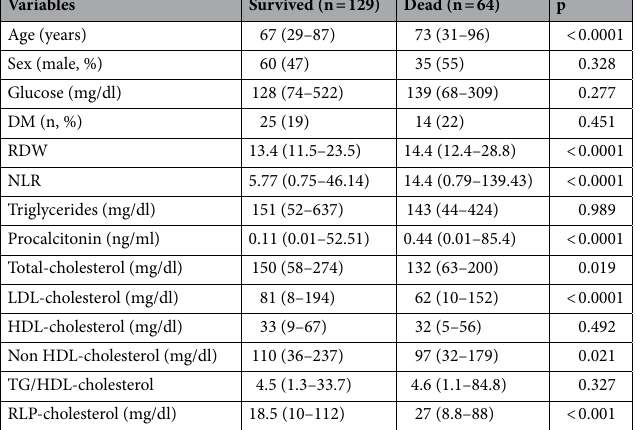
Table 2. Clinical and biochemical characteristics of COVID-19 patients according to death. Results expressed as Median (range). Mann–Whitney or Chi square test according to data distribution. DM diabetes mellitus, RDW red cell volume distribution width, NLR neutrophil-to-lymphocyte ratio, TG triglyceride, RL P remnant lipoprotein.